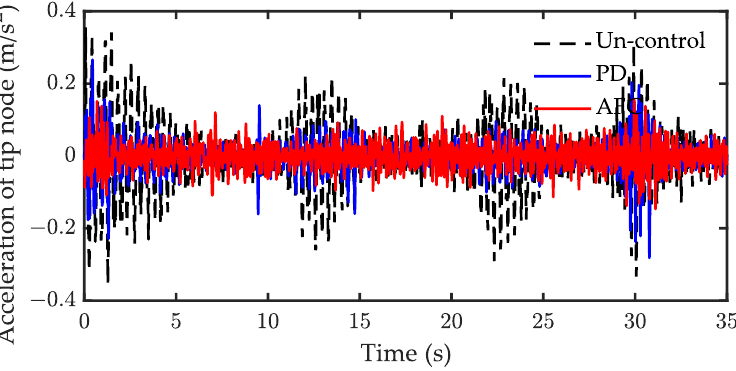
Figure 24. Experiment result of acceleration response for case 2 ( ζ = 20,000).